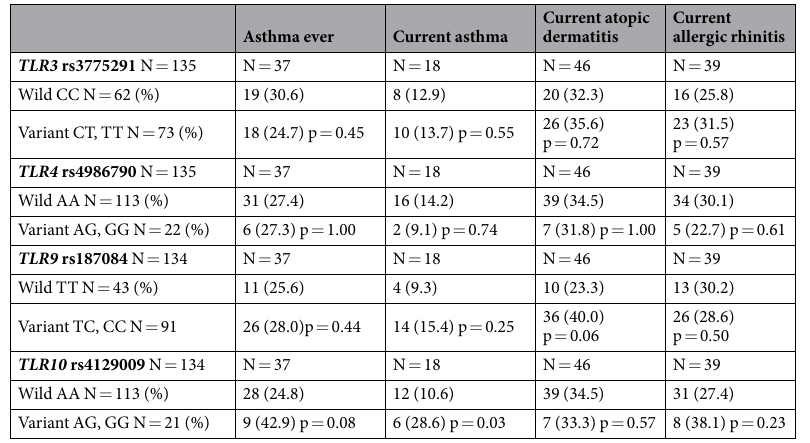
Table 2. Genotypes of TLR3 rs3775291, TLR4 rs4986790, TLR9 rs187084, and TLR10 rs4129009 encoding genes in relation to asthma and allergy at preschool age in 135 former bronchiolitis